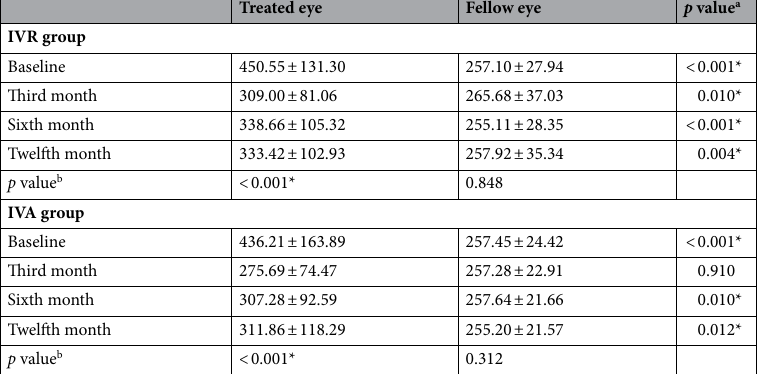
Table 4. Central macular thickness (μm) before and after intravitreal injection. IVR, group that received intravitreal ranibizumab injection; IVA, group that received intravitreal aflibercept injection. a Comparison between the treated and fellow eyes during each period (Mann–Whitney U -test). b Comparison between the baseline and twelfth month for each value (Wilcoxon signed-rank test). * p